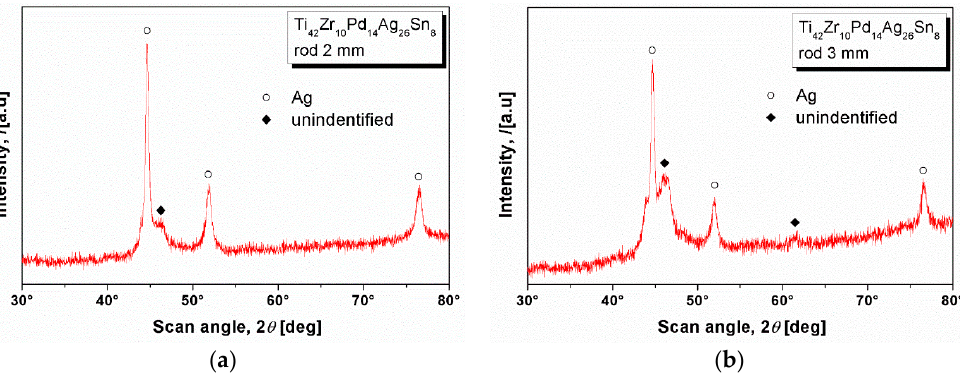
Figure 5. XRD patterns of the Ti 42 Zr 10 Pd 14 Ag 26 Sn 8 bulk sample with ( a ) 2 mm; and ( b ) 3 mm diameter.